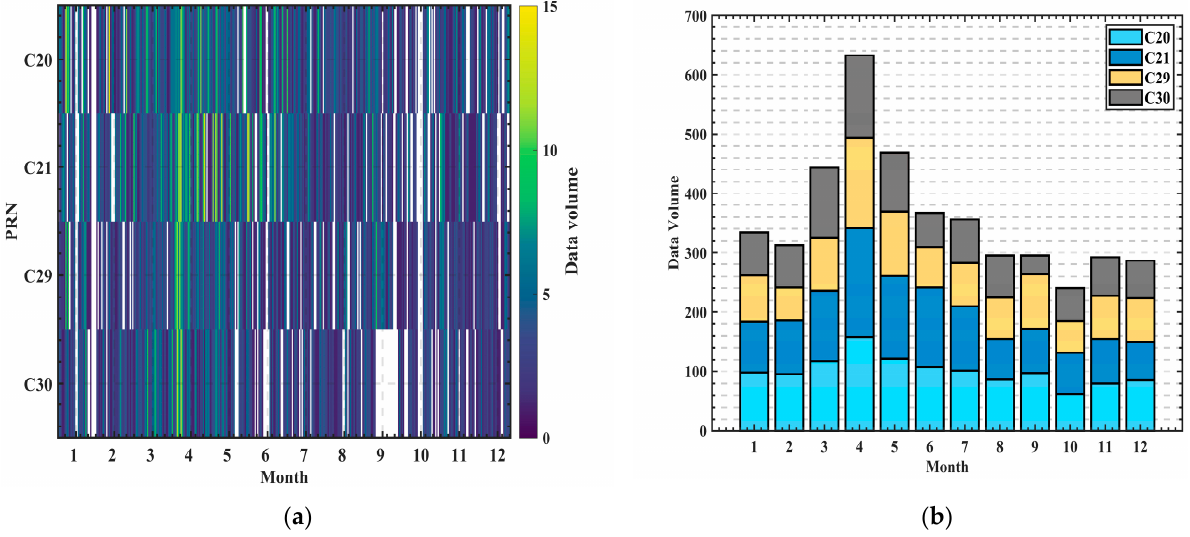
Figure 2. The daily ( a ) and monthly SLR observations ( b ) of BDS-3 provided by ILRS in 2020. Table 3. The number of SLR observation arcs and NPs of BDS-3 satellites in 2020.